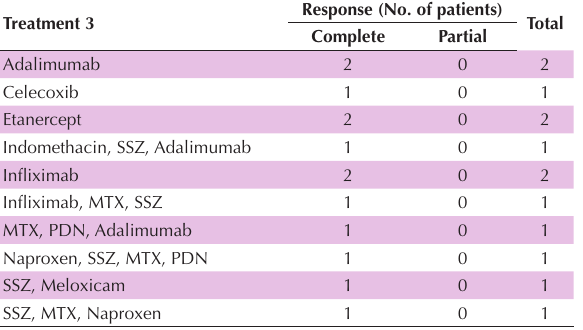
Response (No. of patients) Complete